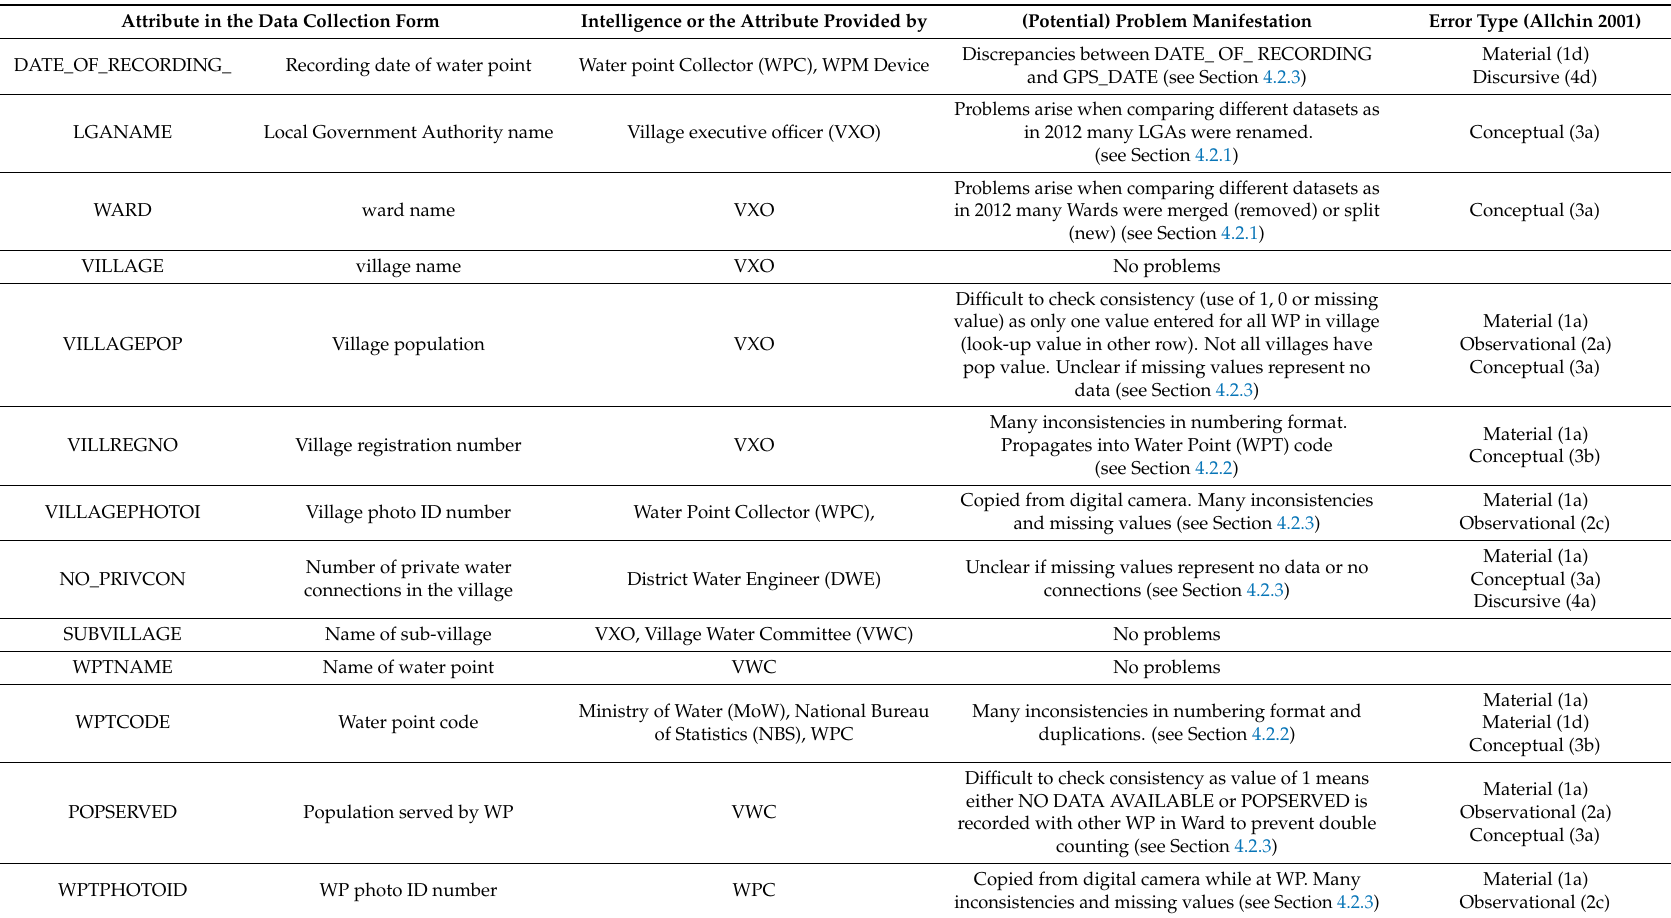
Table A1. Field data (attributes) collected during water point mapping in Tanzania from 2010 to